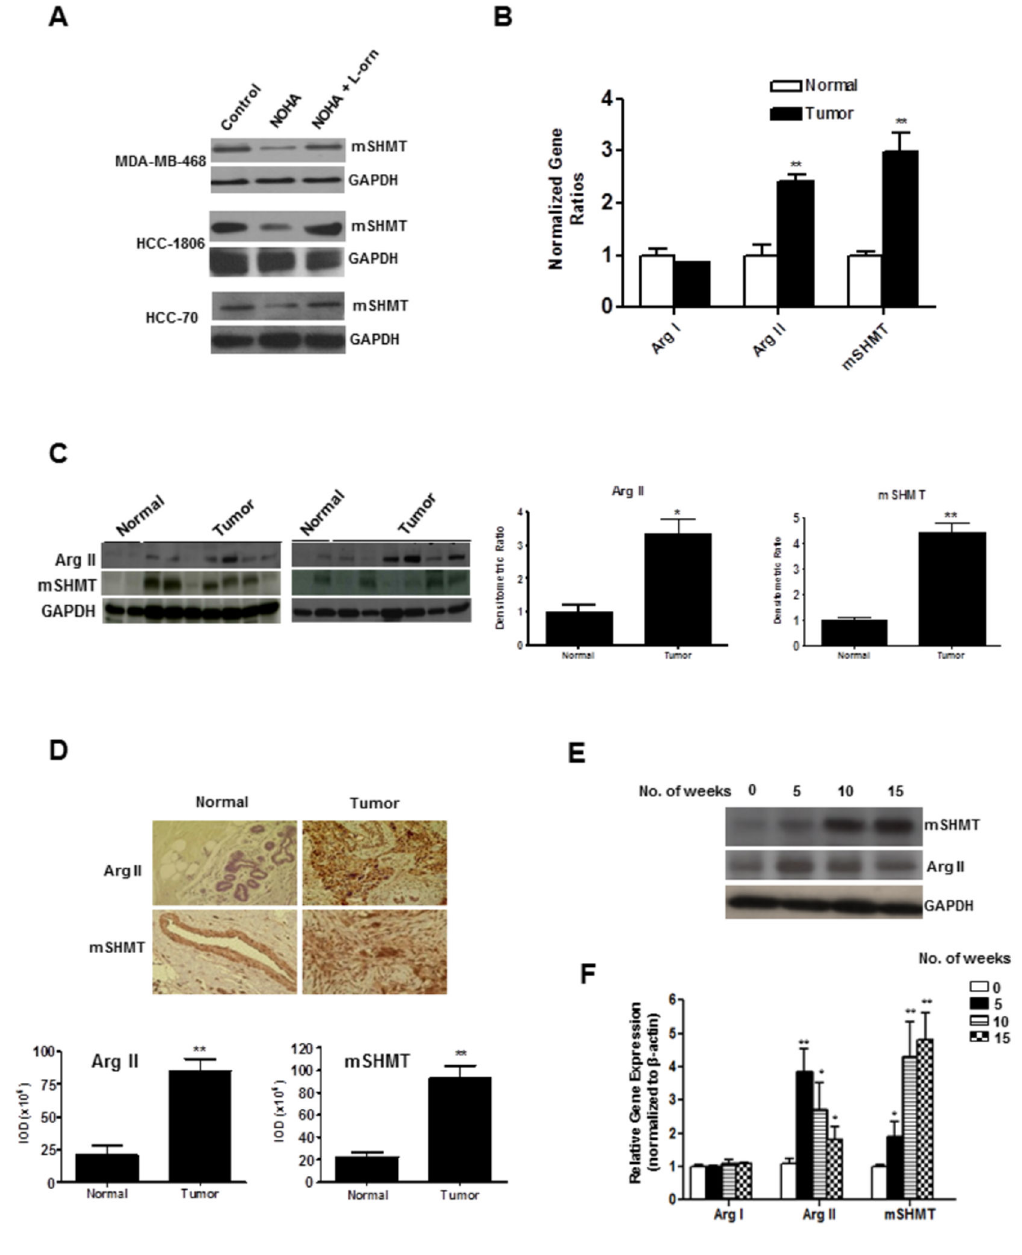
Figure 4. A , Western blot analysis of high Arg II expressing breast cancer cells MDA-MB-468, HCC 1806 and HCC 70 treated either with NOHA (1mM) alone or in combination with L-ornithine (0.5mM). B , Real-time quantitative PCR analysis showing selective induction of Arg II and mSHMT mRNA expression in fresh/frozen human breast tumor and matched normal tissues of Arg I, Arg II and mSHMT gene expression. C , Western blot analysis of Arg I, Arg II and mSHMT protein expression in normal and human breast tumor tissues (right panel) and densitometric quantitation analysis of protein expression (left panel). D , Top Panel, Immunohistochemical analysis of paraffin-embedded normal and breast tumor sections; Bottom Panel, Quantitative analysis of Arg II and mSHMT immuno-positive cells using ImagePro software as described in “materials and methods”. E , Time- course of induction of Arg II and mSHMT protein and F, gene expression in xenografts obtained from nude mice after injection of MDA-MB-468 (5x10 6 ) cells *, p≤0.05; **, p≤0.01.